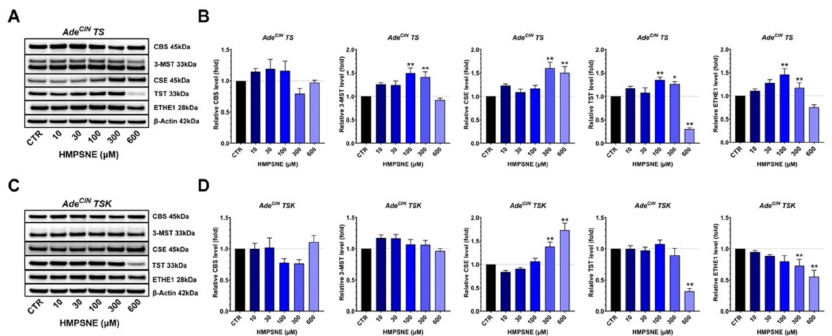
Figure 6. Effect of pharmacological inhibition of 3-MST on the expression of various H 2 S- producing and H 2 S-metabolizing enzymes in Ade CIN TS and Ade CIN TSK organoids . ( A , B ) West- ern blot analysis of H 2 S-producing and H 2 S-metabolizing enzymes in Ade CIN TS organoids in presence of increasing concentrations of HMPSNE. ( C , D ) Western blot analysis of H 2 S-producing and H 2 S-metabolizing enzymes in Ade CIN TSK organoids in presence of increasing concentrations of HMPSNE. Analysis was performed at 48 h. CBS refers to the 45 kDa, truncated form, which was the CBS isoform predominantly present in these organoids. Data represent mean ± SEM of at least 4 independent experiments. * p < 0.05, ** p < 0.01 compared to